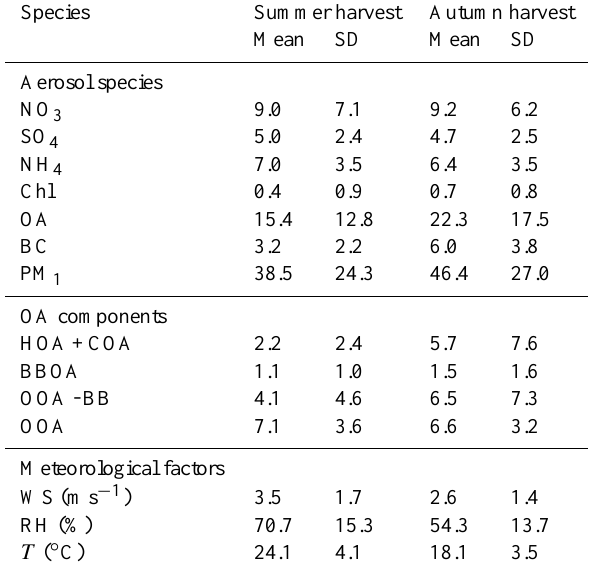
Table 1. Mean mass concentrations (µgm − 3 ) and standard devi- ation (SD) of PM 1 (NR-PM 1 + BC) species, OA components and meteorological factors (i.e., WS, RH, and T ) during the harvest sea- sons. Species Summer harvest Autumn